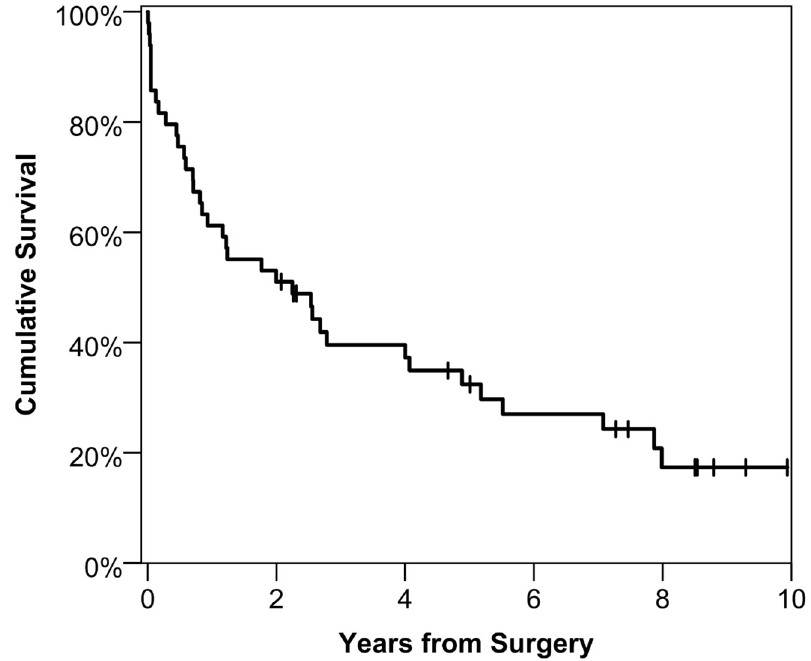
Figure 1. Kaplan–Meier Curve of Postoperative Survival. The analyses of associations between preoperative TTE and postoperative survival were then repeated using a time-to-event approach (Table 3). Preoperative RV size re- mained a significant predictor of survival in this analysis (Figure 2A, p = 0.008), with an estimated survival rate at three years of 50% vs. 22% for those with normal RV size vs. severe RV dilatation. This analysis also identified LVEF as a significant predictor of long-term survival (Figure 2B, p = 0.038), with a three-year survival rate of 42% in those with normal LVEF, whilst the single patient with moderately impaired LVEF died 18 days after surgery. Table 3. Association Between TTE Parameters and Long-Term Survival.